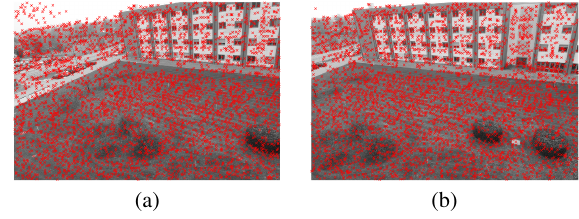
Figure 1. Feature positions for a pair of images.